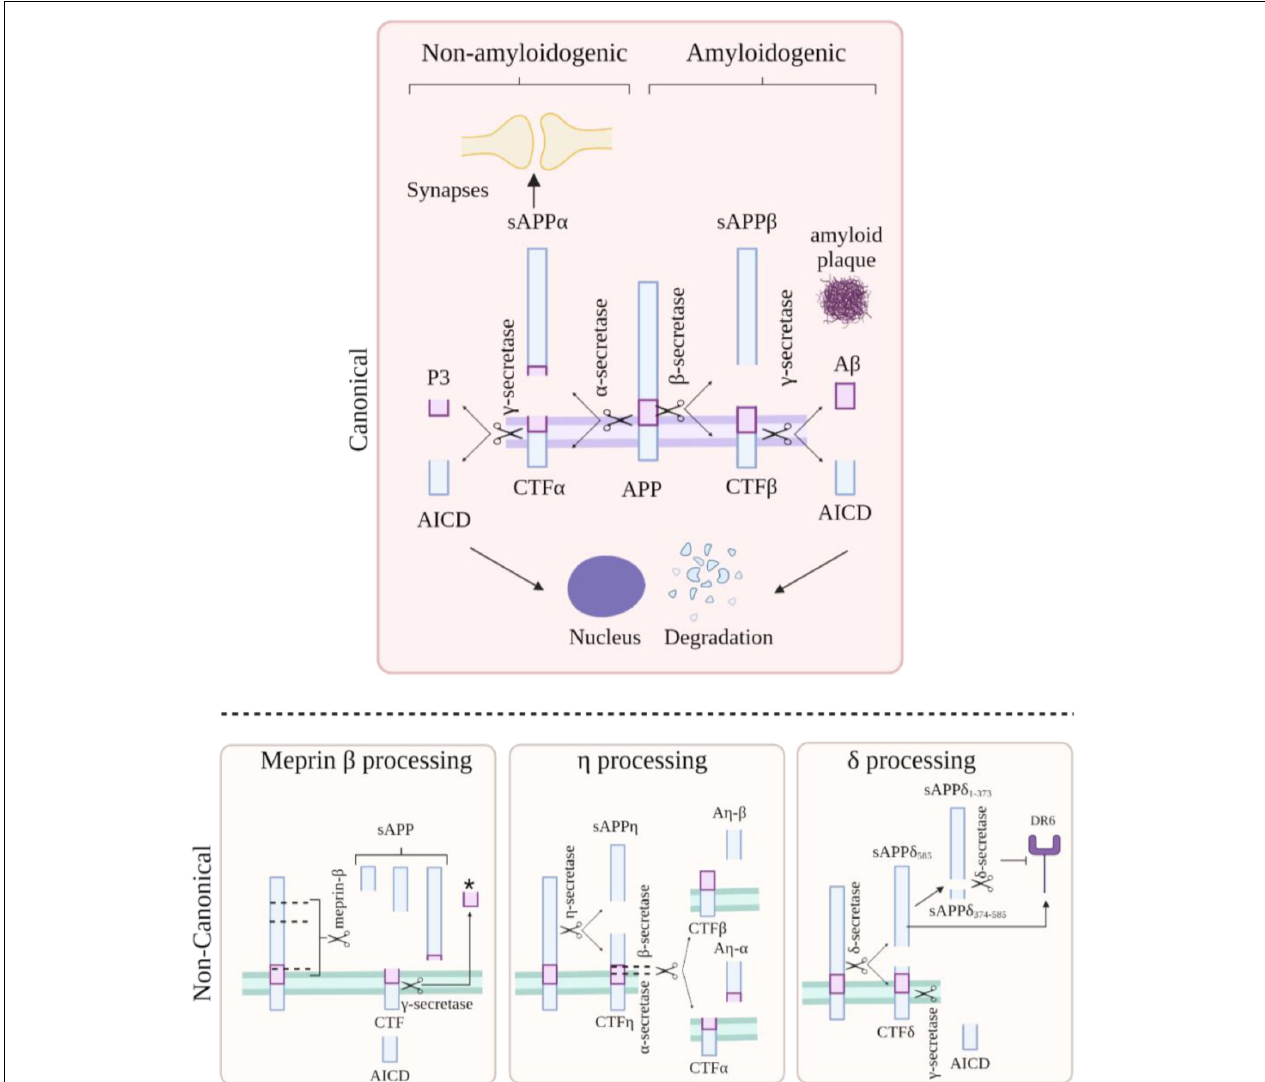
FIGURE 2 | Amyloid precursor protein (APP) cleavage. APP can undergo canonical (top) and non-canonical (bottom) processing. In the amyloidogenic pathway (top, right side), APP is processed by β -secretase and γ -secretase resulting in the formation of A β peptides, APP intracellular domain (AICD) and sAPP β . In the non-amyloidogenic pathway (top, left side), APP is cleaved by α -secretase and γ -secretase resulting p3 peptide, AICD, and sAPP α . Meprin- β cleavage (bottom left) generates three soluble APP fragments; the remaining CTF fragment can be further cleaved by γ -secretase giving rise to a smaller fragment indicated by * and AICD. APP cleavage by η -secretase (bottom, middle panel) generates an APP (sAPP η ) and a CTF η fragment which can be further processed by either α or β -secretase and then by γ -secretase resulting in the formation of A η - α / β and a CTF α or β fragment. APP cleavage by δ -secretase (bottom right) gives rise to a fragment which can activate the death cell receptor (DR6) promoting cell death or can be further cleaved to generate a fragment unable to bind the receptor; the remaining CTF δ fragment can be processed by γ -secretase form the intracellular domain AICD. Created with